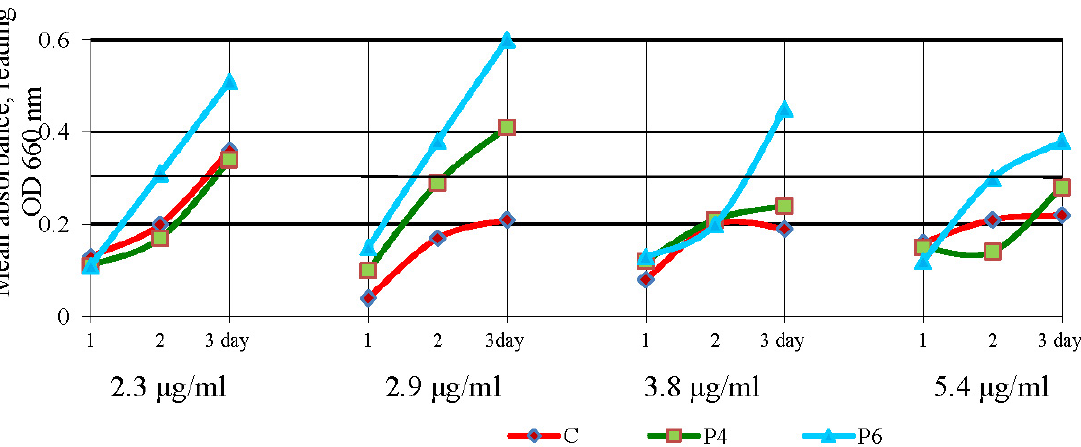
Figure 10. Growth of Escherichia coli ( E. coli ) under the action of oxytetracycline in complex with polyphosphate ester-type transporters during cultivation in a liquid medium for three days. The maximum inhibition of E. coli was found on day 1 (19.1%), with growth decreasing on the second (13.3%) and third (3.7%) days of cultivation. Inhibition of E. coli by oxytetracycline + P6 was detected only on the first day of cultivation (14.6%) at a dose of 2.3 µg/mL. Therefore, the low concentration of oxytetracycline + P4 (8 µg/disk and 2.3 µg/mL) provides maximum growth inhibition of E. coli , compared to oxytetracycline hydrochloride.